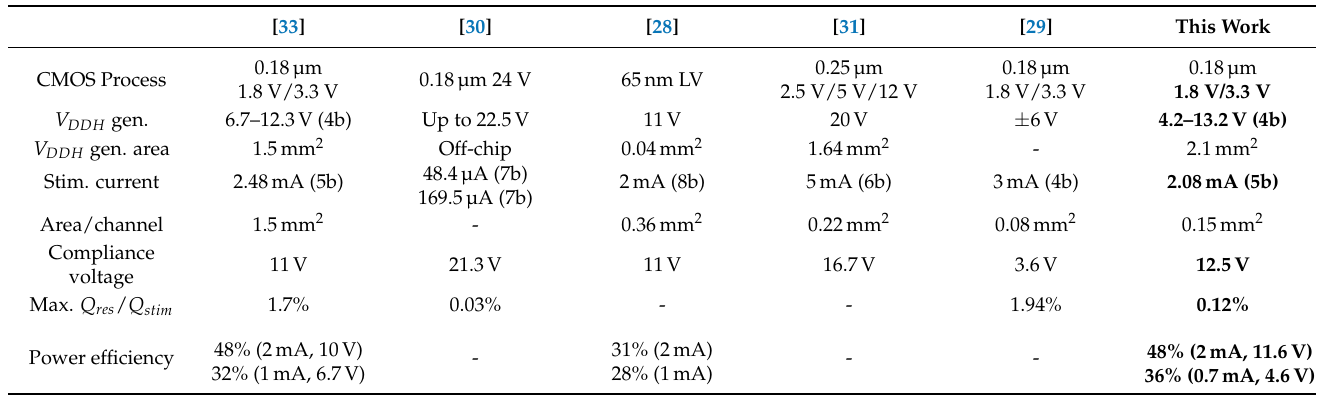
Table 2. Performance comparison with previously reported